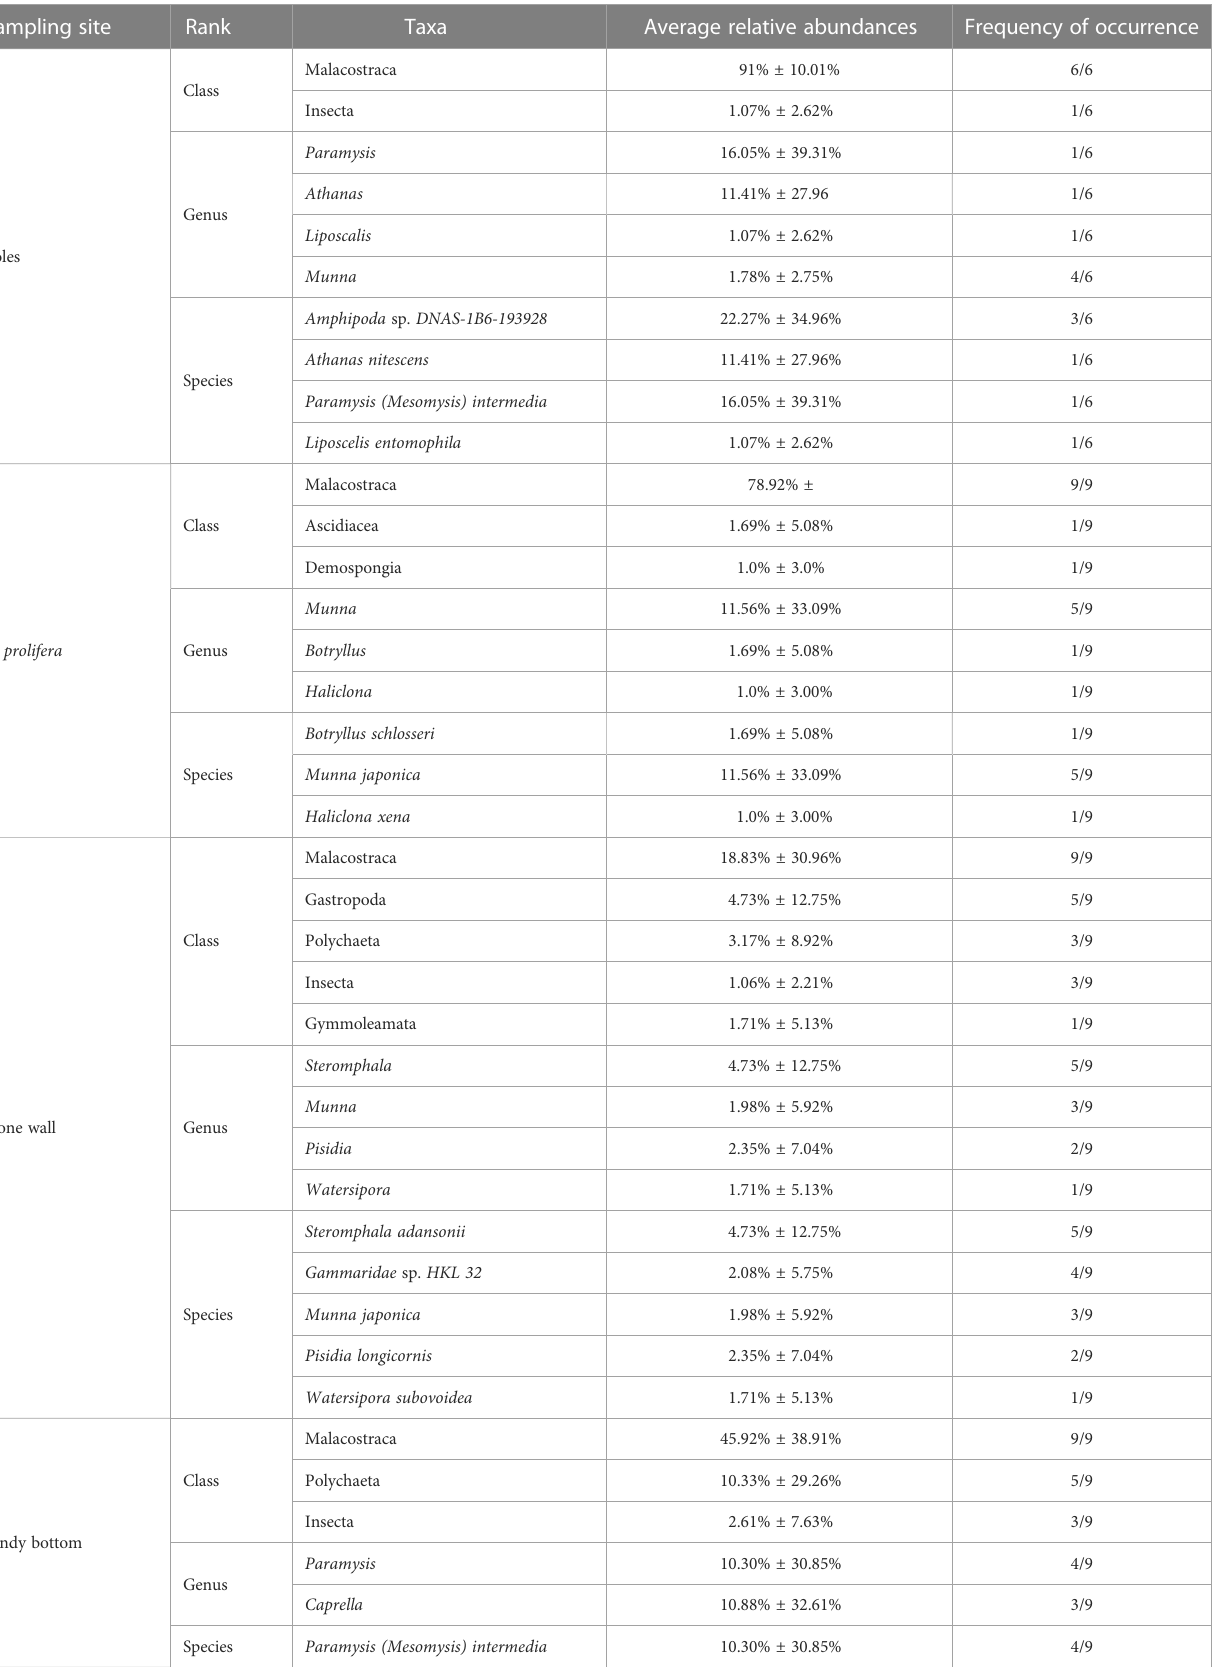
TABLE 3 The most abundant (relative abundance ≥ 1%) classes, genera, and species for each sampling site. Sampling